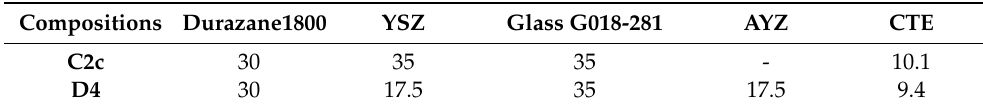
Table 1. Compositions of prepared composite coatings (vol %) and their coefficient of thermal expansion (CTE, × 10 − 6 K − 1 ).